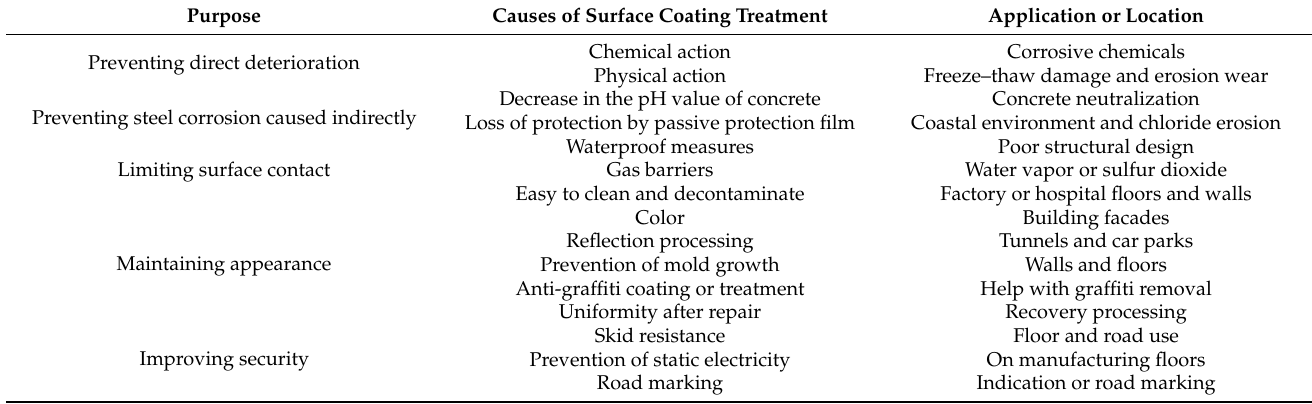
Table 1. Causes of concrete surface sealing treatment [23].